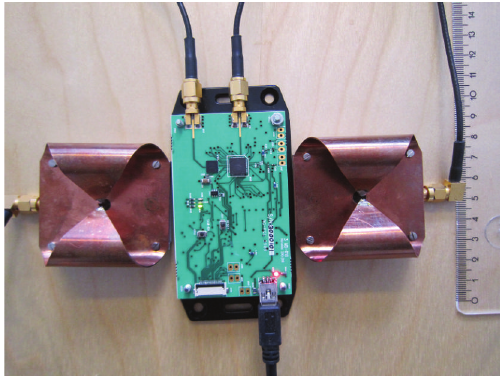
Figure 1: The compact UWB radar system for indoor and through- wall ranging and tracking.